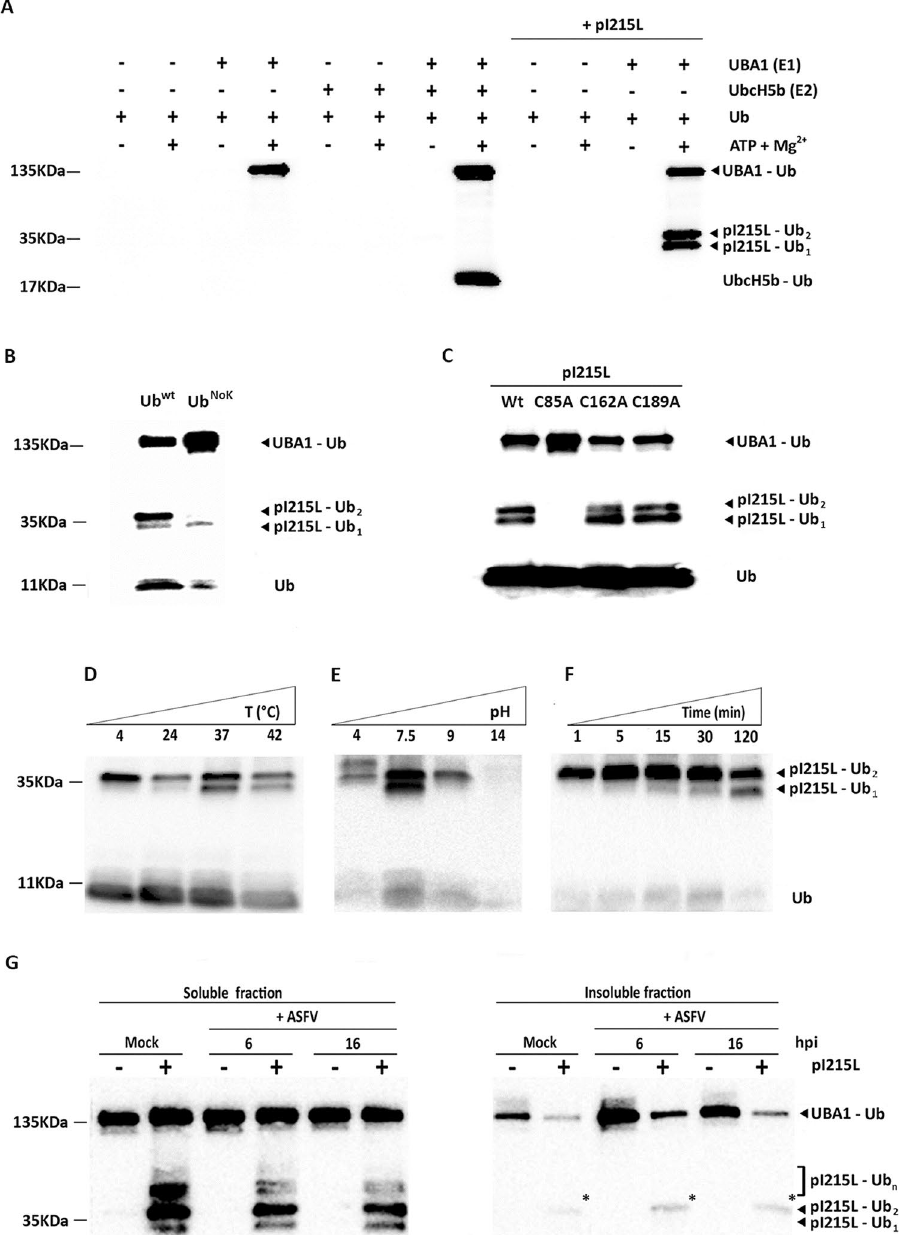
Figure 1. pI215l acts as an E2-ubiquitin conjugating enzyme. (A) Results from an in vitro ubiquitination assay showed that recombinant pI215L binds one or two ubiquitin molecules, in an ATP- and Mg 2 + -dependent manner, and in the presence of an E1 ubiquitin-activating enzyme (UBA1). Reaction mixtures were incubated 2 hours at 37 °C, quenched with a non-reducing protein loading buffer, and then subjected to polyacrylamide gel electrophoresis. (B) When the ubiquitination assay was performed using an ubiquitin that is mutated in all lysine residues (Ub NoK ), the di-ubiquitinated forms of pI215L were not detected. (C) The residue cysteine-85 is essential for the E2-like activity of pI215L. Site-directed mutagenesis revealed that replacement of Cys-85 by an alanine residue led to an absence of ubiquitinated species, whereas the substitution of the Cys-162 or Cys-189 residue does not hamper the formation of ubiquitinated forms of pI215L. (D) pI215L forms thioester bonds with ubiquitin in a wide range of temperatures, although mono-ubiquitinated forms of pI215L were less detectable at 4 °C and 24 °C. (E) pI215L binds ubiquitin in a broad range of pH values, with mono-ubiquitinated forms only found at a pH value of 7.5. (F) Poly-ubiquitinated forms of I215L were detected after a short incubation period of 1 min, whereas the mono-ubiquitinated forms were detected later (5 min), showing increased concentrations in longer incubation times (e.g. 30, 60 minutes). (G) Mono- and poly-ubiquitinated forms of pI215L were mainly found in the Triton X-100-soluble fractions harvested at 6 and 16 hpi. In detergent-insoluble fractions, only the di-ubiquitinated form of pI215L was faintly detected (asterisks). Blots of Fig. 1(D to F) were cropped to improve clarity, full-length blots are presented in supplementary Figure S1. Fig. 1(G) is composed by two individual blots obtained from soluble and insoluble